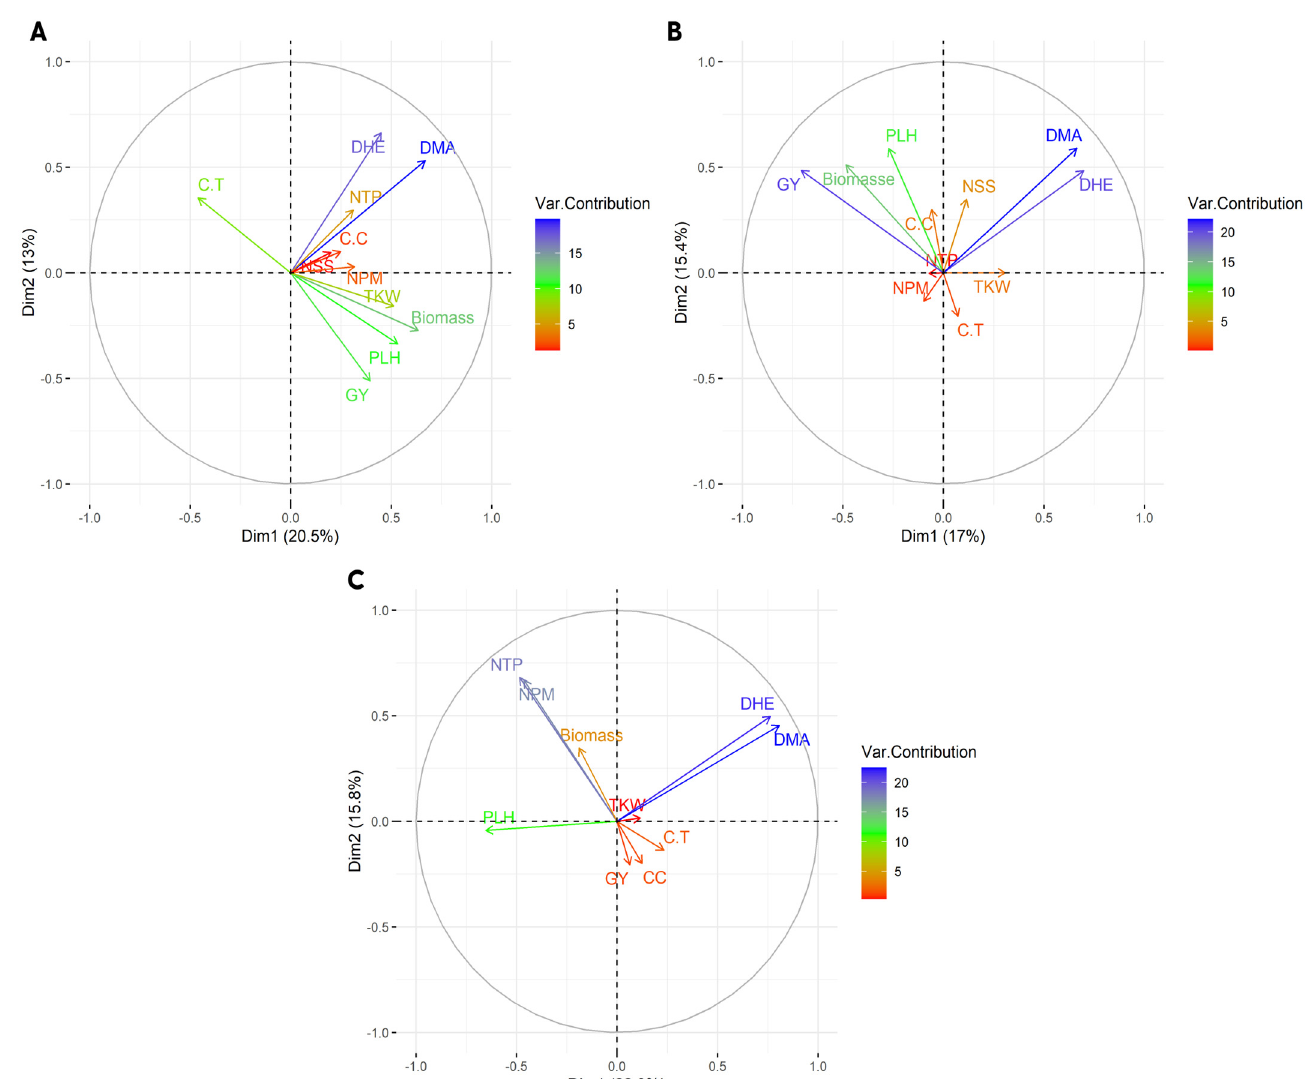
Figure 2. Principal component bi-plot analysis of 200 bread wheat genotypes grown during two seasons (2020 and 2021) under the rainfed regime ( A ) irrigated regime, ( B ) at Sidi Al-Aidi station and rainfed regime at Merchouch station, ( C ) in Morocco.